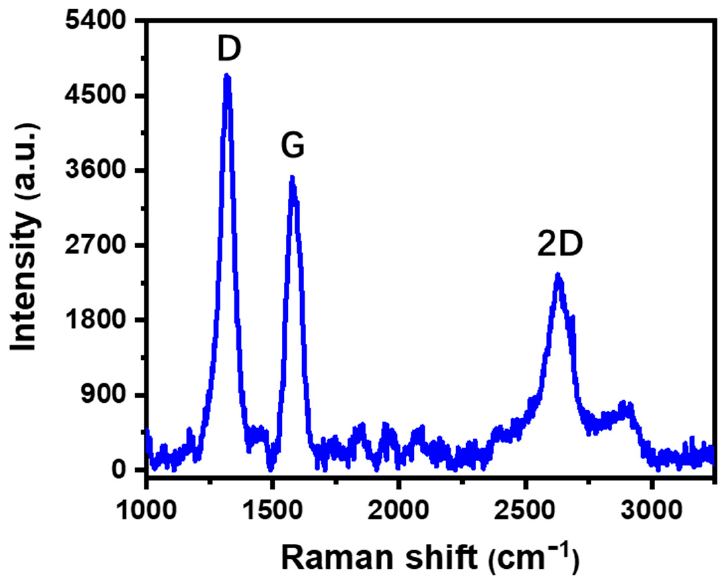
Figure 4 . Raman spectrum of sintered PI tape.